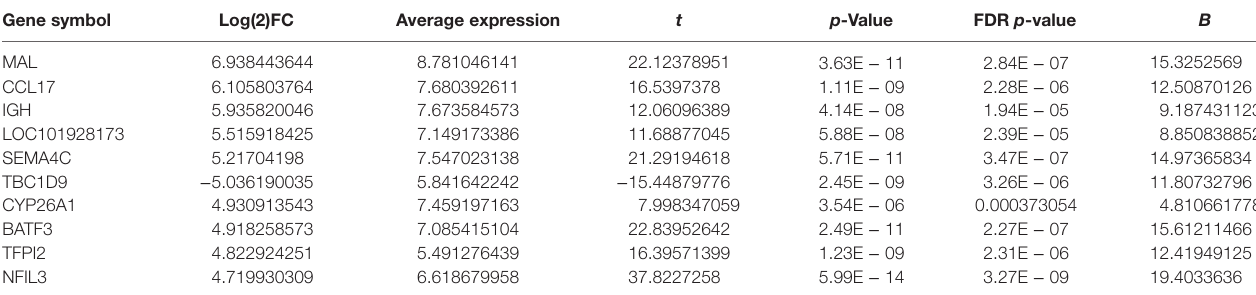
TaBle 1 | Top 10 differentially expressed genes in anti-cD40/il-4-treated B-cells versus unstimulated